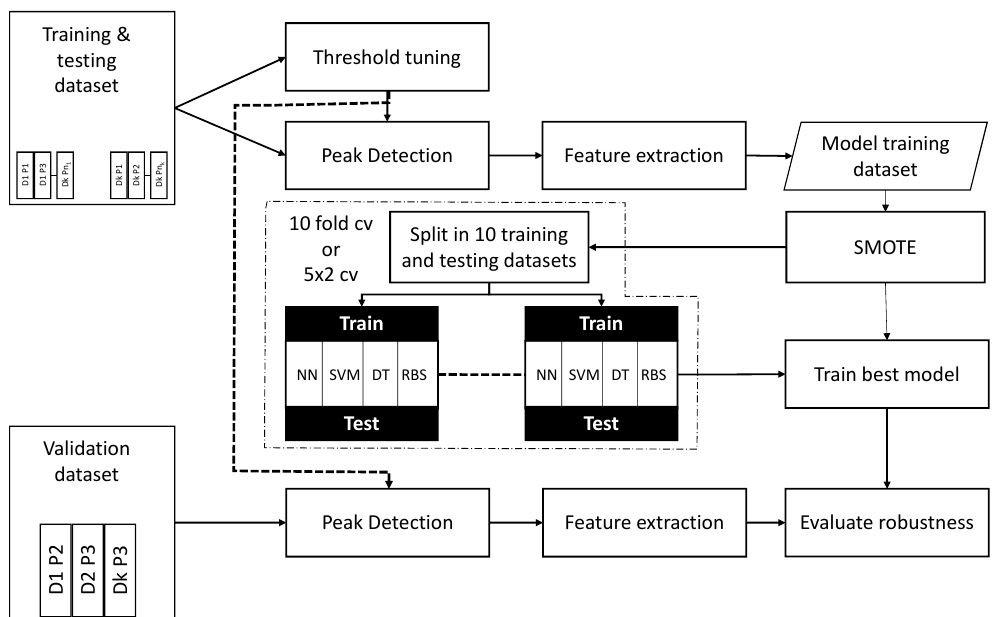
Figure 4. The machine learning process within the cross-validation scheme. The training and testing dataset is used for (i) threshold optimization and (ii) peak detection and feature extraction. The labeled dataset is then used for the machine learning process to find the best modeling option. The best option is then evaluated with the validation dataset once processed so the real performance of the system can be